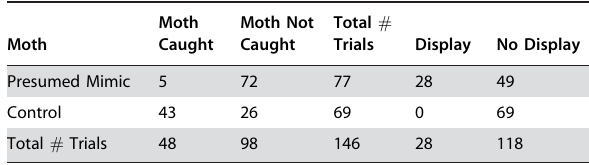
doi:10.1371/journal.pone.0000045.t002